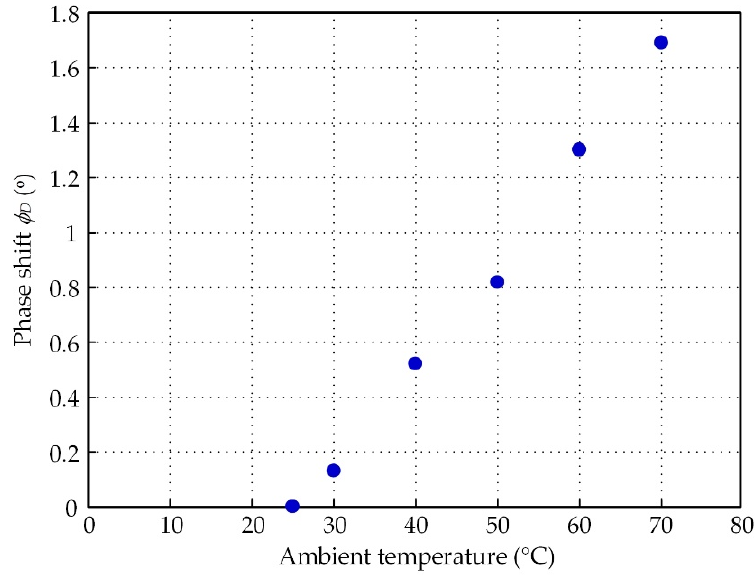
Figure 6 . ( a ) Experimental setup; ( b ) prototype of the proposed circuit. Figure 6. ( a ) Experimental setup; ( b ) prototype of the proposed circuit.